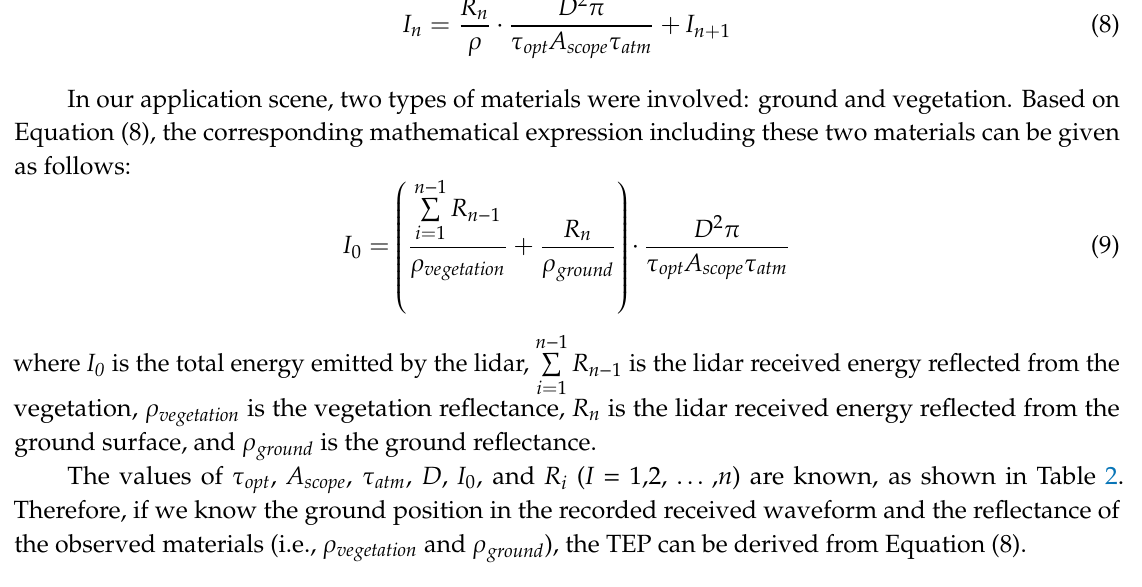
Table 2. The instrument parameters of the GLAS